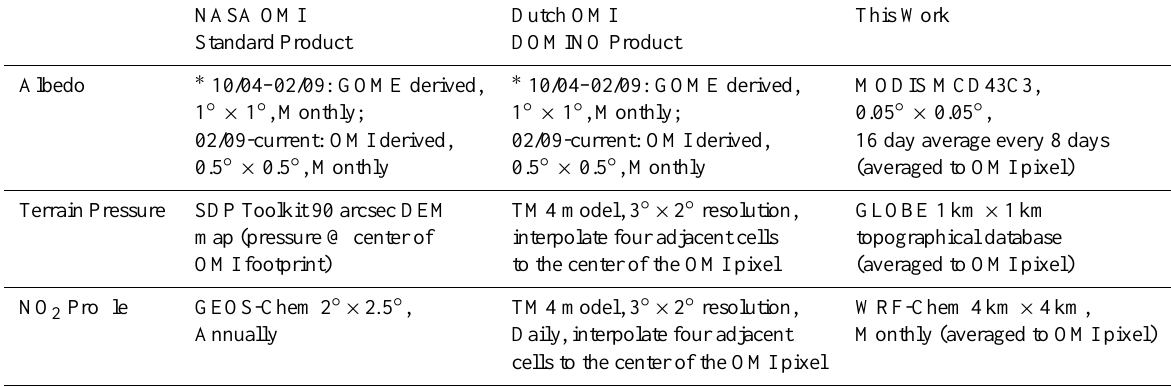
Table 1. Albedo, terrain pressure, and NO 2 vertical profiles in each of the three satellite column NO 2 retrievals studied here. NASA OMI Dutch OMI This Work Standard Product DOMINO Product